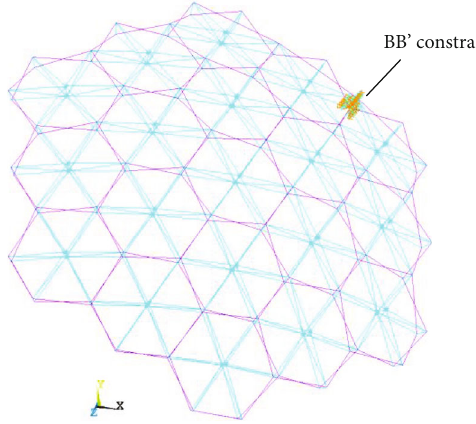
Figure 4: FEM of the modular deployable antenna. Table 1: Thermophysical parameters of antenna materials. Material property